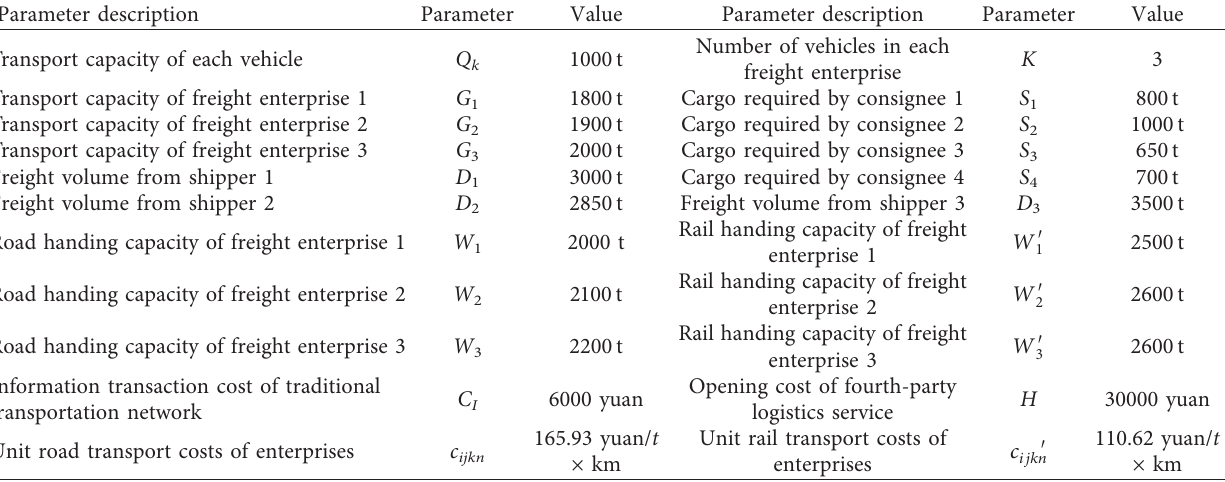
Figure 3: The integrated cost of the small bulk cargo transport Table 5: Parameter of the medium bulk cargo transport network.